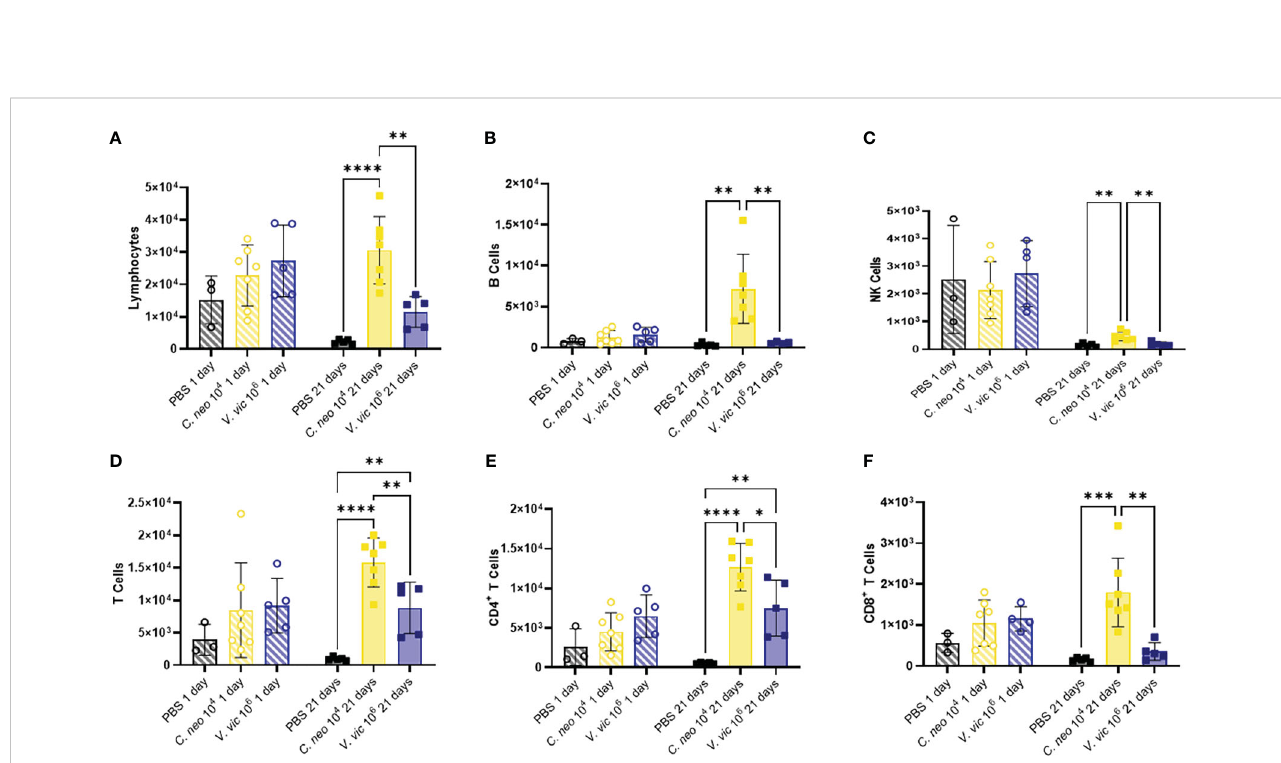
FIGURE 5 Lymphoid populations are elevated in the BALF 21 days following repeated yeast exposure. Cell populations in BALF following repeated exposure to PBS (black), 10 4 C. neoformans cells (yellow) or 10 6 V. victoriae cells (blue) at 1 day post fi nal exposure (circles, crossed bars, left) or 21 days post fi nal exposure (squares, solid bars, right). Cells = cell number. (A) Lymphocytes, (B) B Cells, (C) NK Cells, (D) T Cells, (E) CD4 + T Cells, and (F) CD8 + T Cells. n=3-7 per group, *P<0.05, **P < 0.01, ***P < 0.001, ****P < 0.0001. P values were determined by ordinary one-way ANOVA with Tukey ’ s multiple comparisons test comparing each exposure together for the same timepoint.